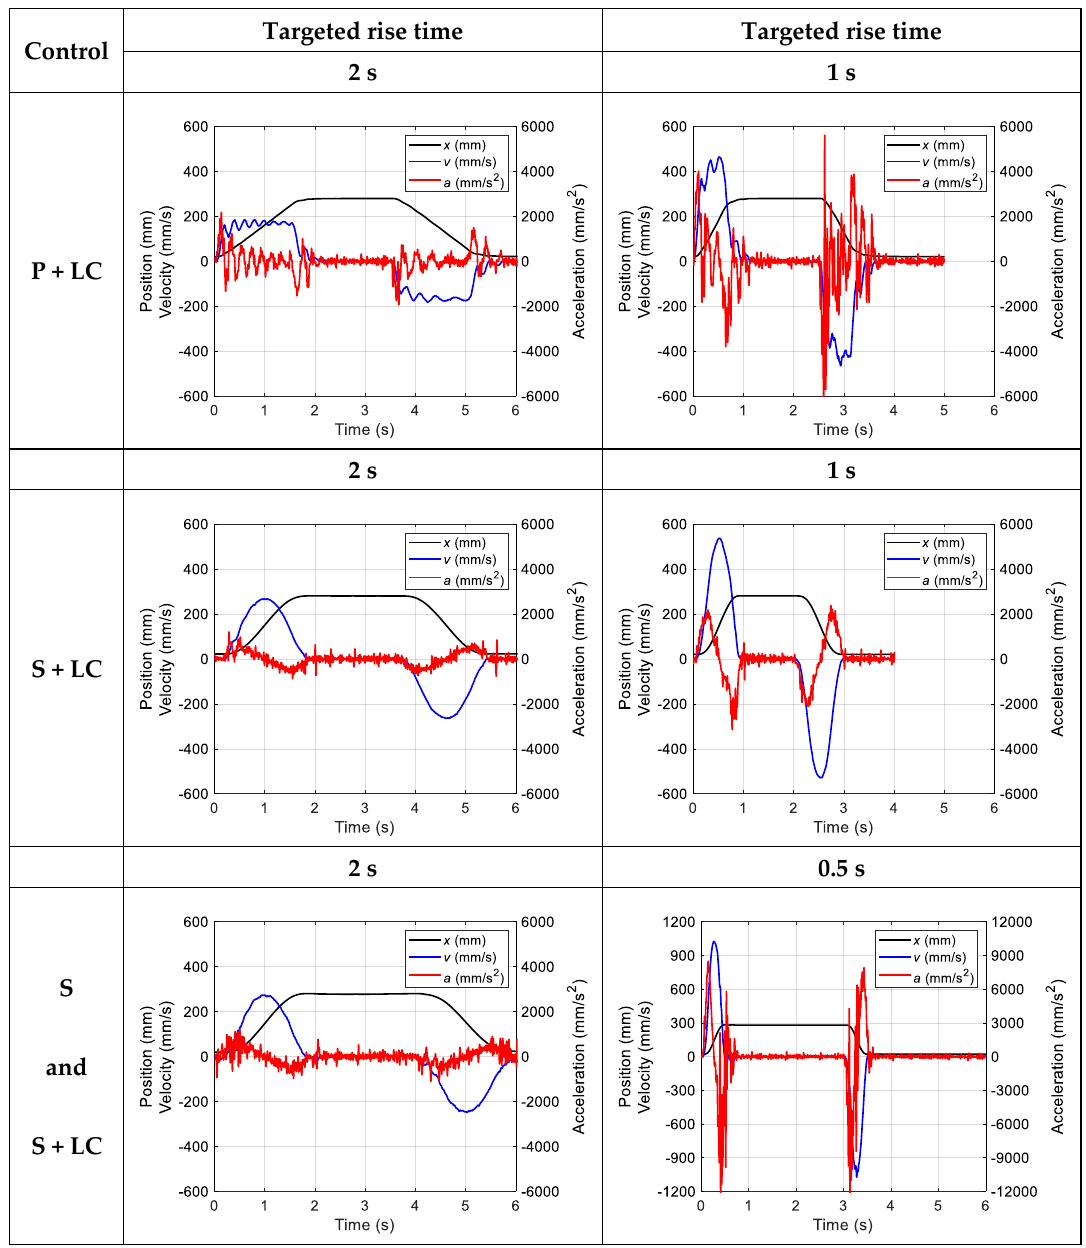
Figure 5. Position, velocity, and acceleration of actuator piston rod with different controllers and rise times.